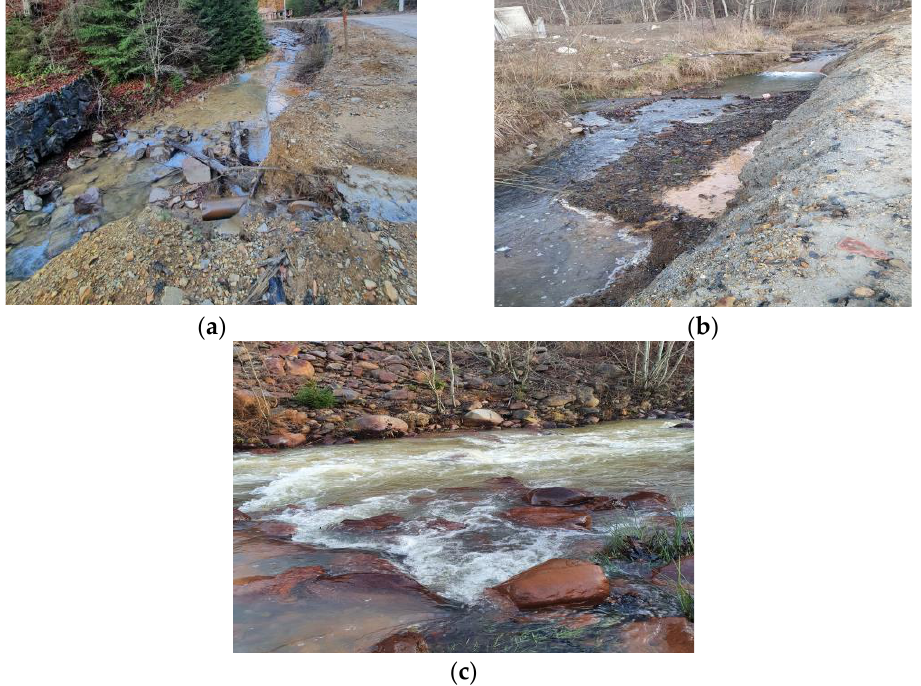
Figure 2. The flow of mine water in Băiuț valley, the Bloaja Tailing Valley and the collector Lăpuș River, Băiuț - Văratec metalliferous mining area, Maramureș county, Romania (photos: I.A.P.): ( a ) Băiuț valley; ( b ) Bloaja Tailing Valley; ( c ) Lăpuș River.